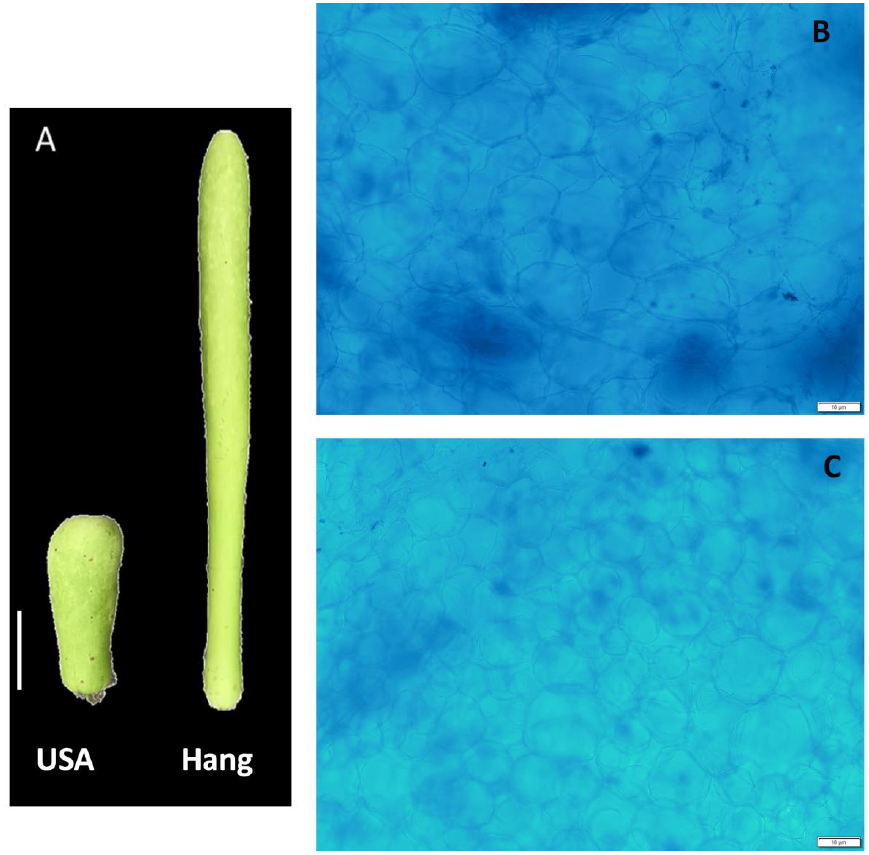
Figure 1. Phenotypes of the bottle gourd fruit Hang and USA . ( A ) Pictures of fruits of the two cultivars at maturity; bar = 5 cm ( B ) Histological photograph of pericarp section in Hang fruit; ( C ) Histological photograph of pericarp section in USA fruit; bar = 10 µm. Table 1. Sequencing data output statistics .